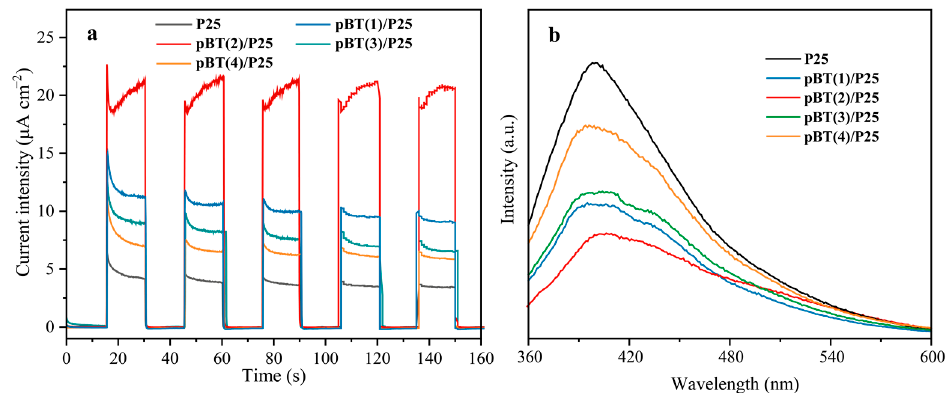
Figure 6. ( a ) Transient photocurrent responses of P25 and pBT(x)/P25 under a 300 W full-arc Xe lamp irradiation; and ( b ) photoluminescence spectra of P25 and pBT(x)/P25 with an excitation wavelength of λ = 330 nm.